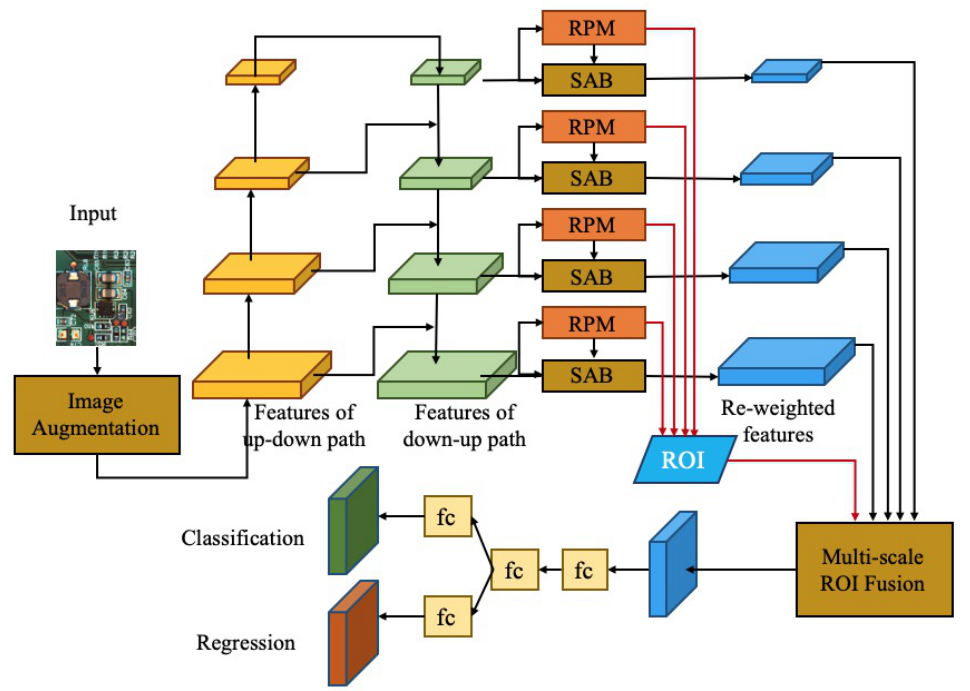
Figure 3. Overall structure of our chip-detection neural network.